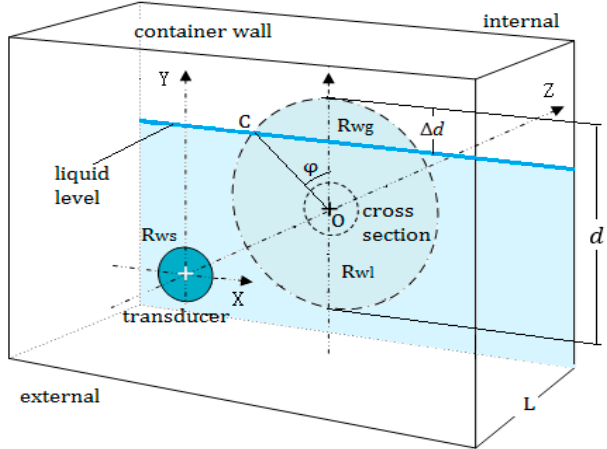
Figure 6. The calculation of the echo sound pressure received by the transducer. R wg and R wl represent the reflection coefficients at two parts of the circle section, respectively.